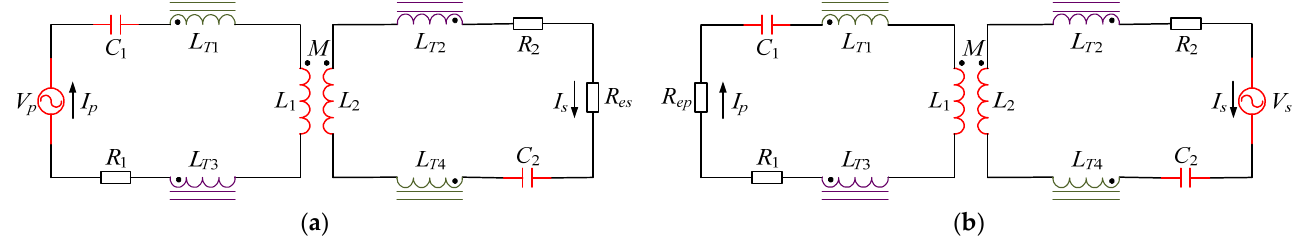
Figure 8. Equivalent circuit of crosstalk interference between power transfer and information transfer: ( a ) Simplified schematic of forward power transmission channel. ( b ) Simplified schematic of backward power transmission channel.